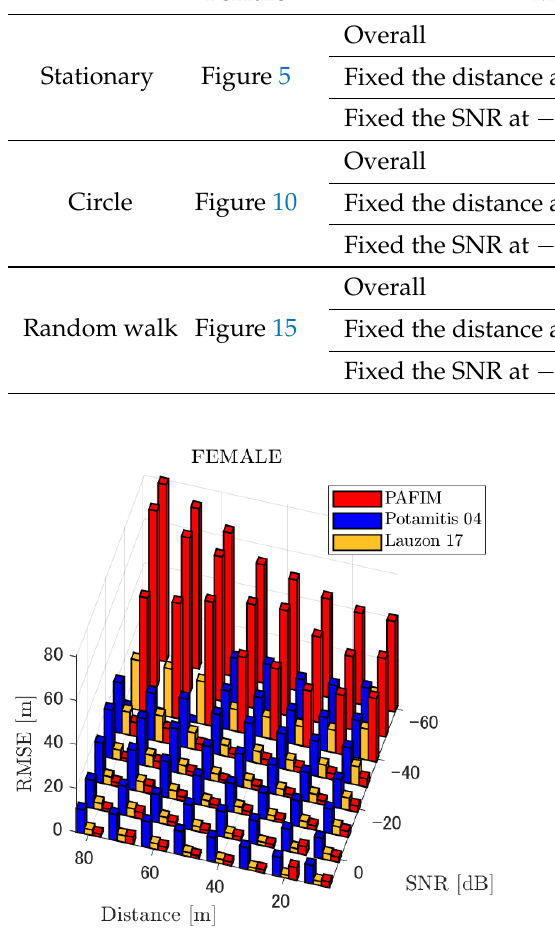
Figure 5. RMSE of tracking a stationary sound source emitting female